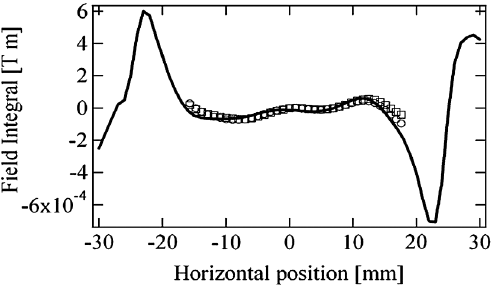
FIG. 11. Transverse variation of the vertical field integrals measured with rotating coils ( ), deduced from closed orbit (cid:7) distortion ( h ) and from horizontal tune shift ( (cid:8) ) tune shifts